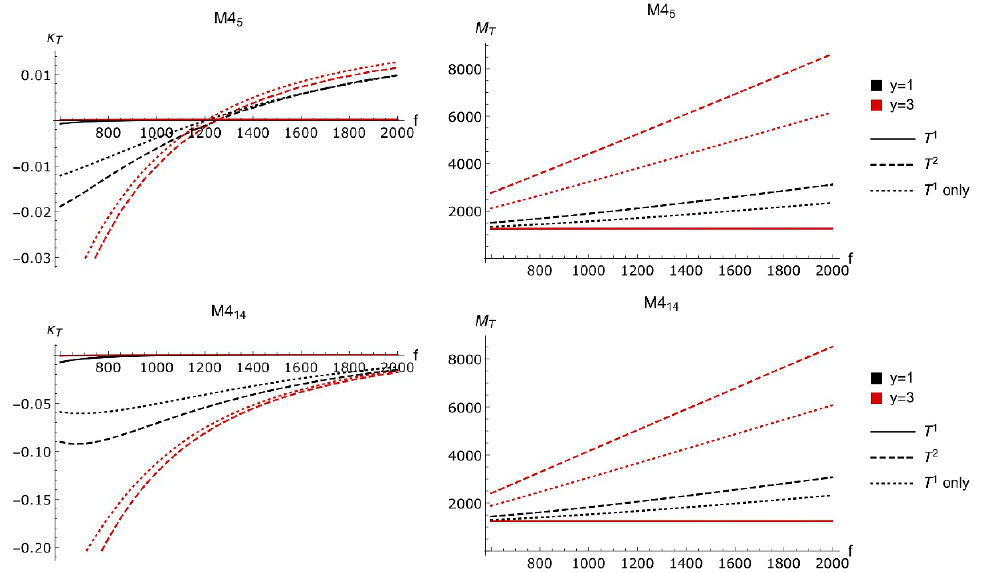
Figure 5 . The masses and Yukawa couplings of the two light top-partners from the M4 5 and M4 14 models, as functions of the coupling f , for M (cid:9)